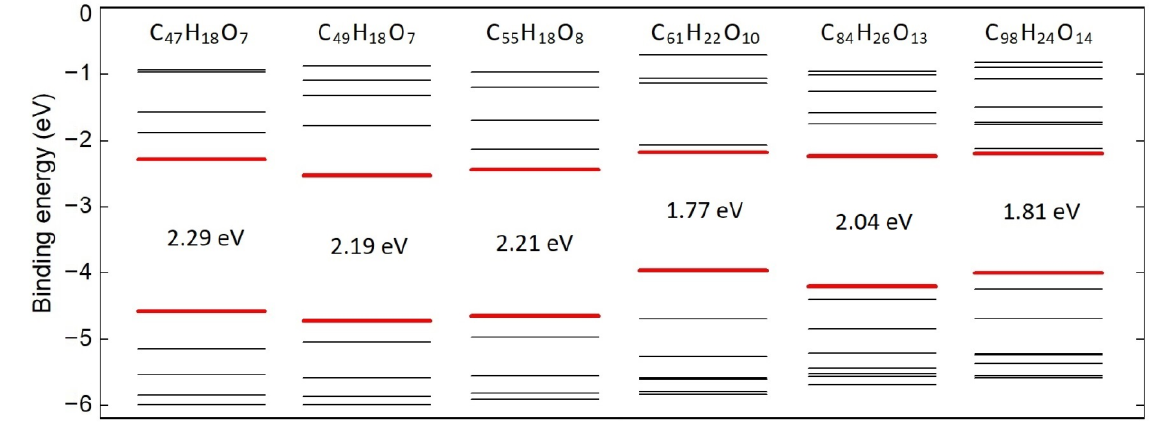
Figure 2. Ground state KS energy levels of rGO fragments.